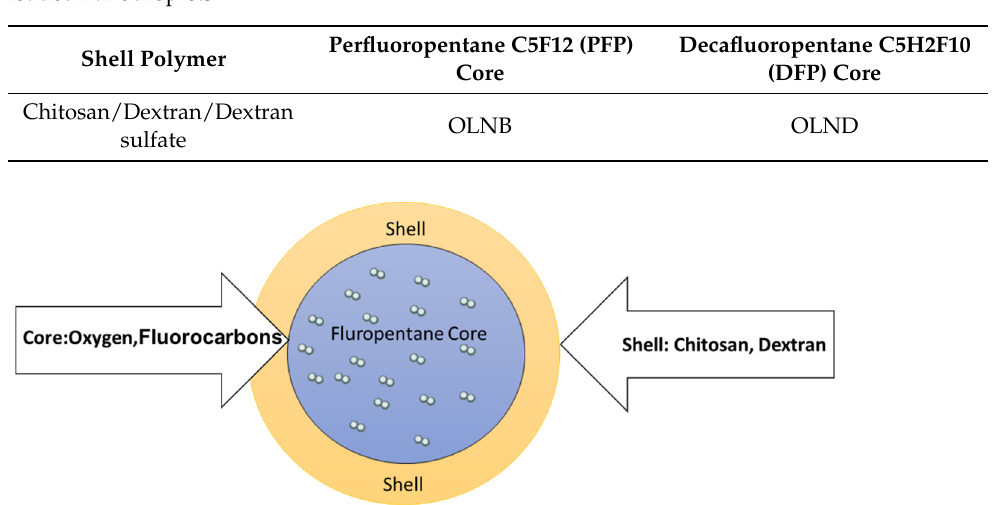
Table 1. Different oxygen-loaded nanosystems. OLNB: oxygen-loaded nanobubbles; OLND: oxygen-loaded nanodroplets.